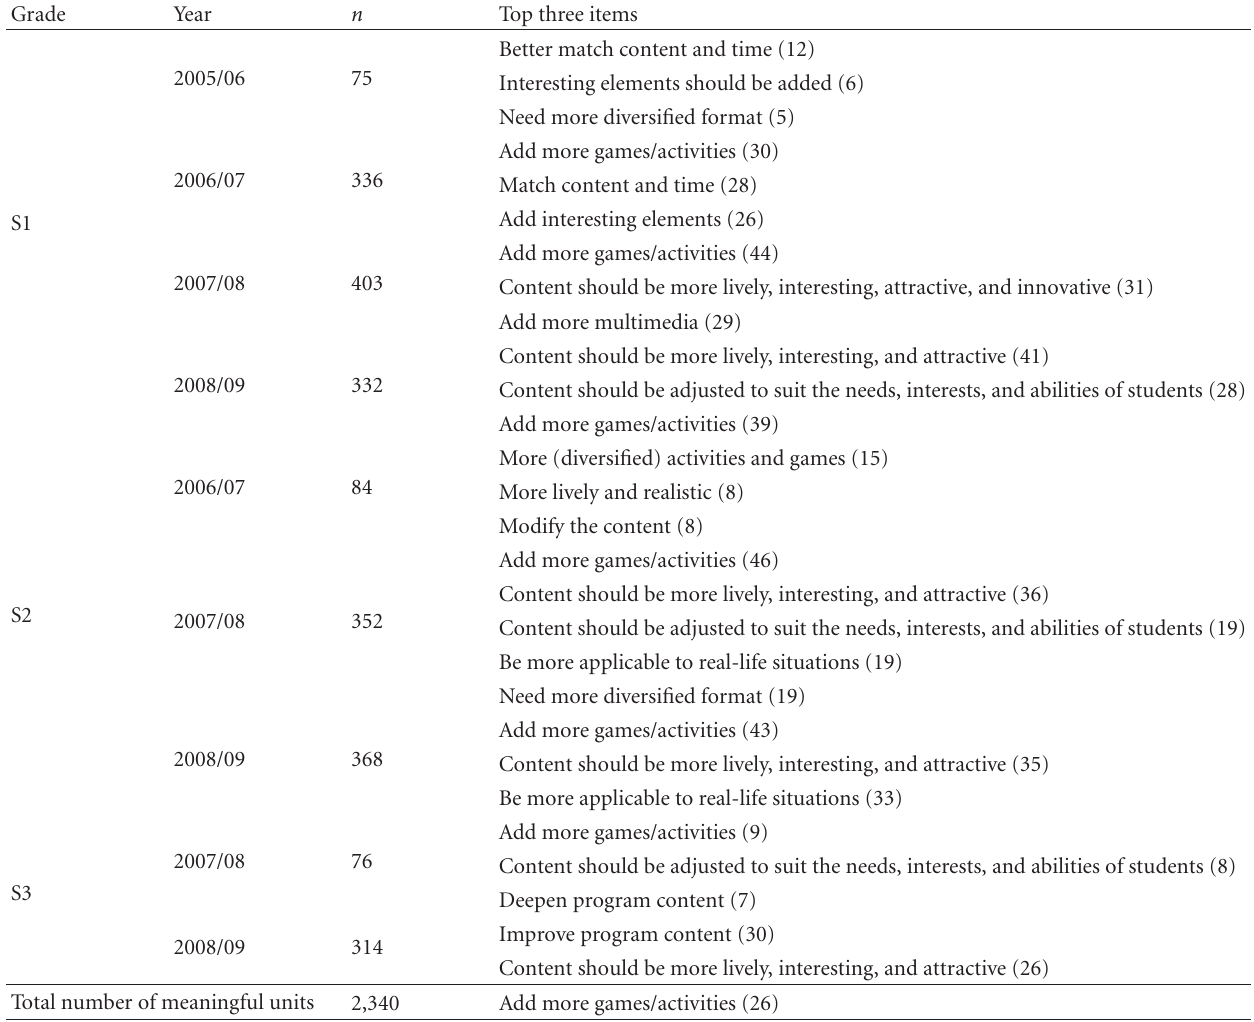
Table 6: Recommendations suggested by the program implementers in di ff erent cohorts.